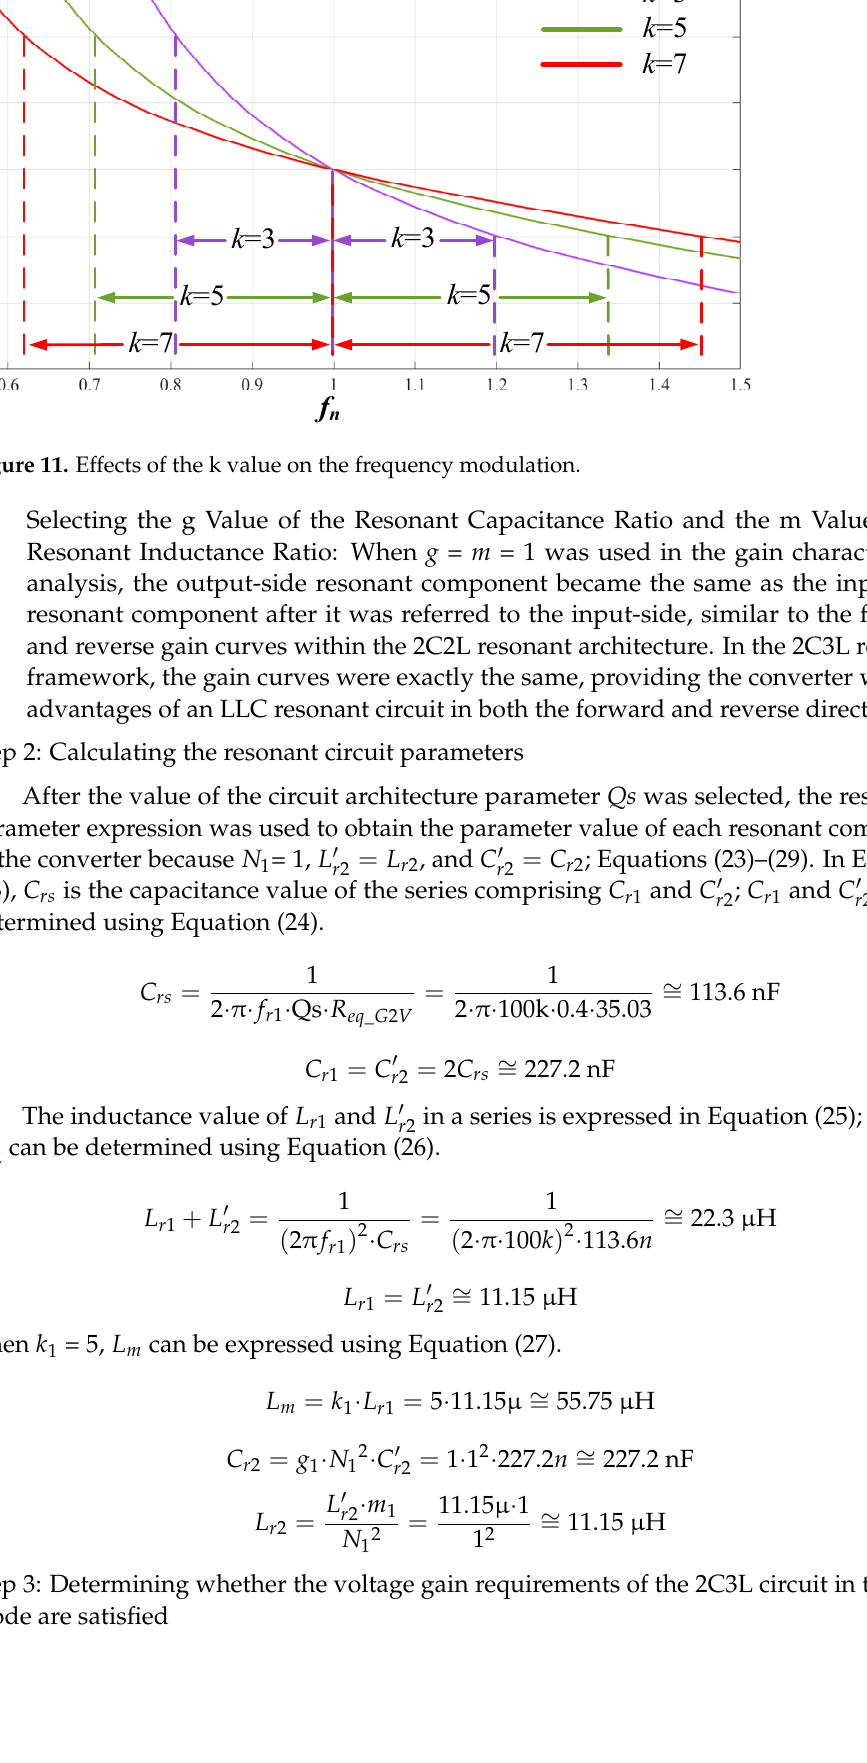
10 of 19 Figure 9. LLC resonant gains under different Q values. Gain f n Qs =0.8 Qs =0.4 Qs =0.6 Qs =0.2 Qs =1 Qs =2 Figure 10. 2C3L resonant gains corresponding to different LLC Qs values. 2.